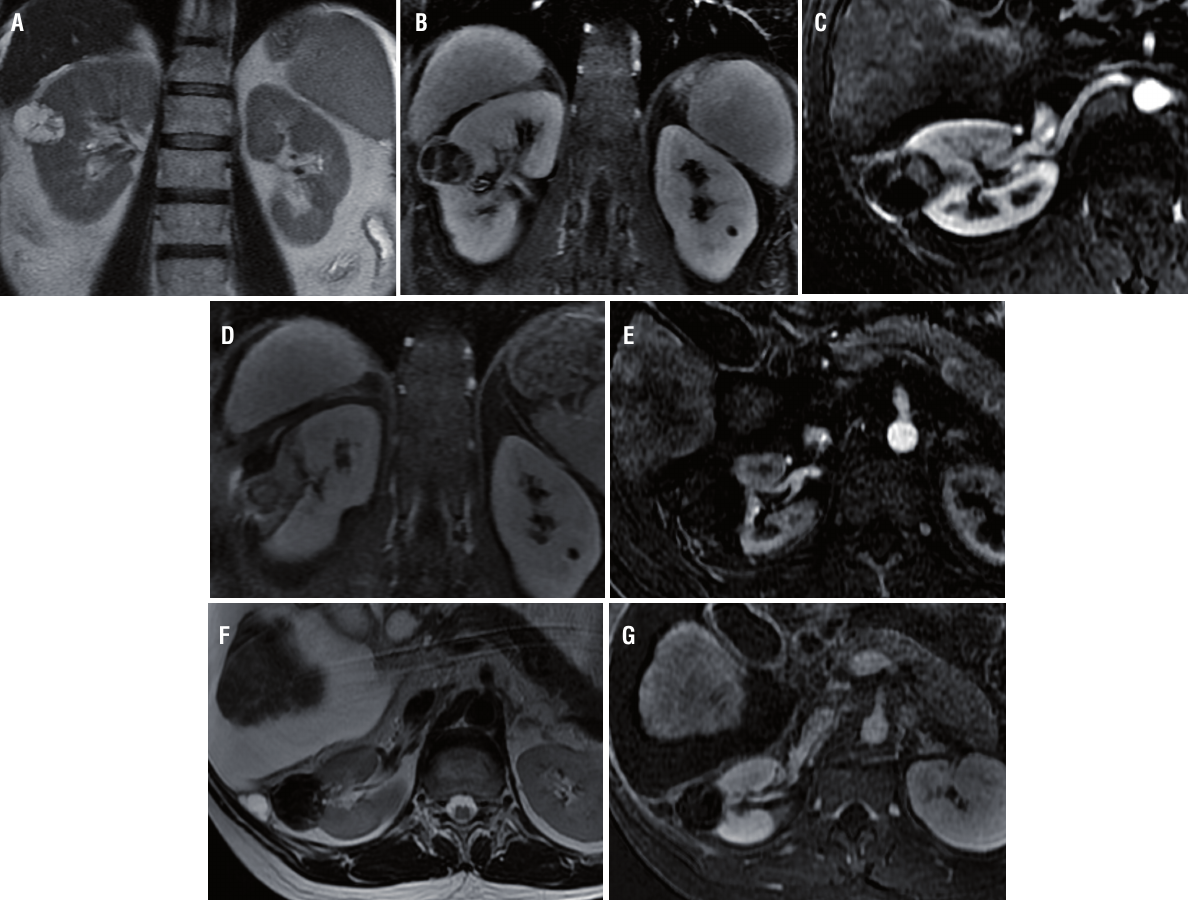
figure 2 – (a-g) 48-years old man with a Bosniak Iv lesion. Coronal T2-weighted (a), Coronal T1-weighted gradient echo axial MRI sequences with fat suppression (b) and coronal subtraction image (postcontrast arterial phase data - precontrast data) (c) show a cystic renal mass with thickened enhancing septa and a small solid component. Coronal T1-weighted gradient echo axial MRI sequences with fat suppression (d) performed immediately after the procedure show complete ablation of cystic lesion and no measurable enhancement within ablation zone. Axial subtraction image (postcontrast arterial phase data - precontrast data) (e) three months after the procedure show no enhancement and no recurrent of the neoplasm. Axial T2-weighted (f) and axial subtraction image (postcontrast arterial phase data - precontrast data) (g) 3 years after the procedure show ablation changes in the right kidney, without residual enhancement to suggest recurrent